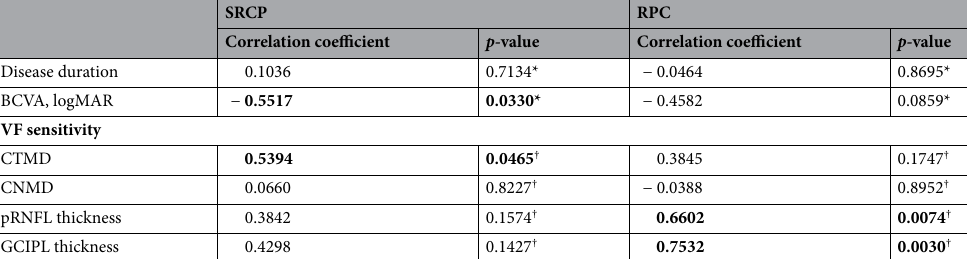
Table 4. Correlation analysis between vessel density changes and structural, and other demographics changes. BCVA best corrected visual acuity, CTMD central temporal mean deviation, CNMD central nasal mean deviation, GCIPL ganglion cell-inner plexiform layer, pRNFL peripapillary retinal nerve fiber layer, RPC radial peripapillary capillary, SRCP superficial retinal capillary plexus, VF visual field. P -values by Spearman* or Pearson’s † correlation with adjustment for age and spherical equivalent refractive errors.